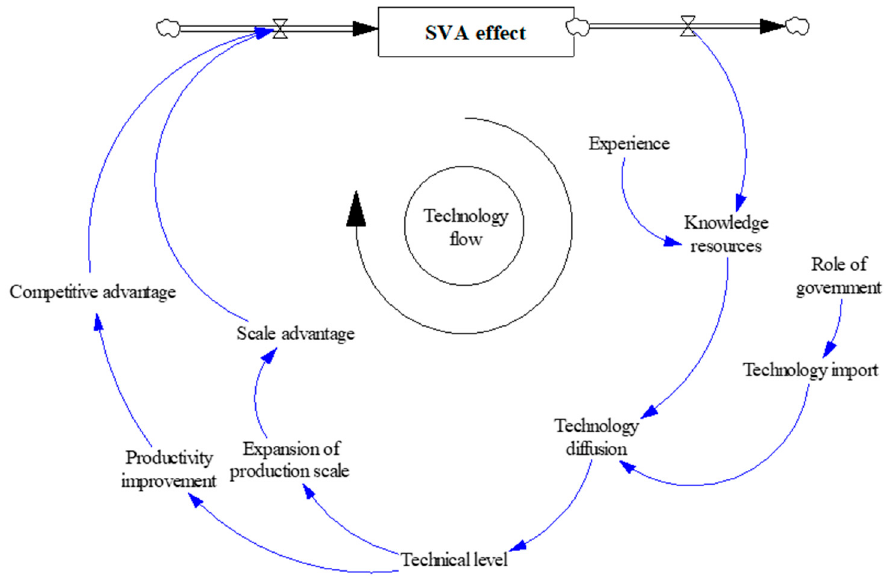
Figure 3. Technology flow causality. Arrows indicate causality; Clockwise arrow indicates positive feedback.